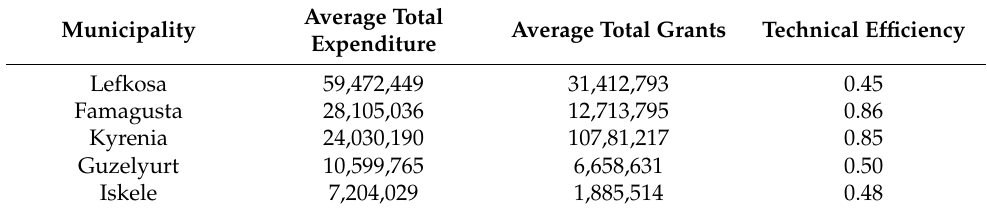
Table 11. Expenditure, Independent Revenue Sources (Grants) and Efficiency of Municipalities between 2004 and